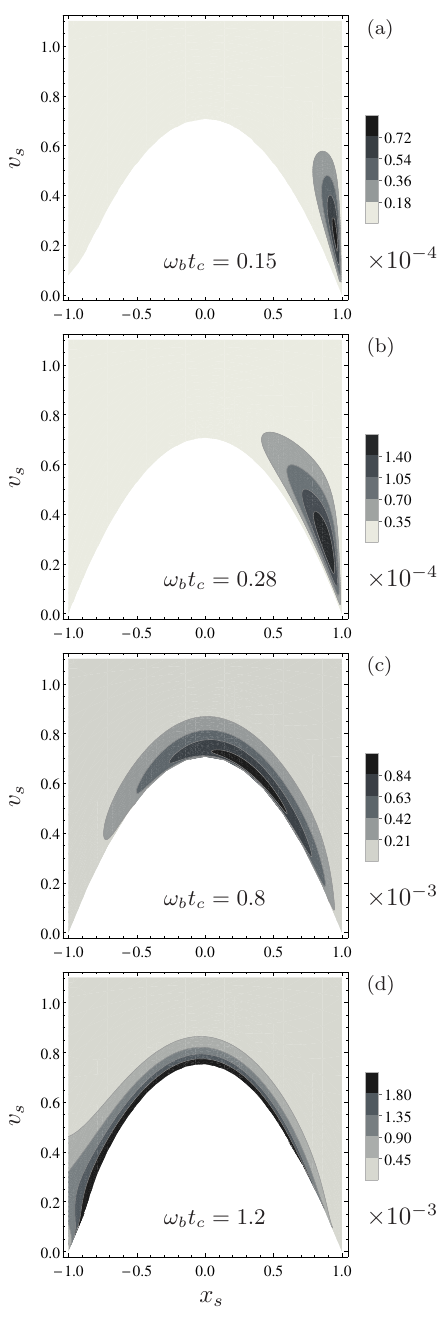
( x ) for increasing values of ω t Figure 5: Contour plot of g , v . In the overdamped x e = 1 s s b c < 1, g ( x ) has a well defined maximum and vanishes on approaching t regime, ω , v b c x e = 1 s s the E = ∆ U parabola. The maximum becomes broader as t grows, as flights from a larger c range of starting positions give a relevant contribution to g . At the transition between the = 1, the maximum disappears as g diverges t overdamped and the underdamped regime, ω b c logarithmically on approaching the E = ∆ U parabola. This behavior persists in the under- damped regime. The disappearance of the maximum of g indicates that the system loses a typical energy scale and a typical length scale on moving from the overdamped to the under- = damped regime. The figure refers to ∆ U = 1 / 4, L = 2, T / ∆ U = 0.21 and x e